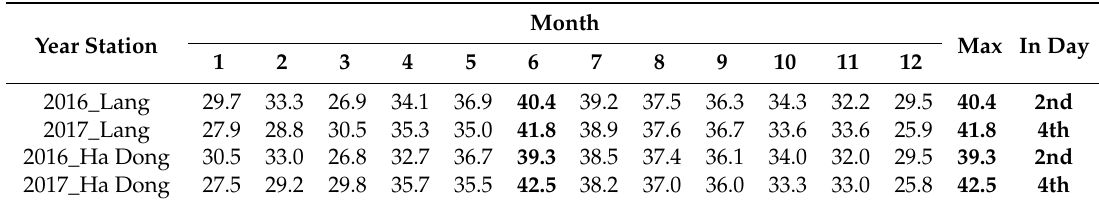
Table 1. Maximum monthly air temperatures (°C) in Hanoi in 2016 and 2017.